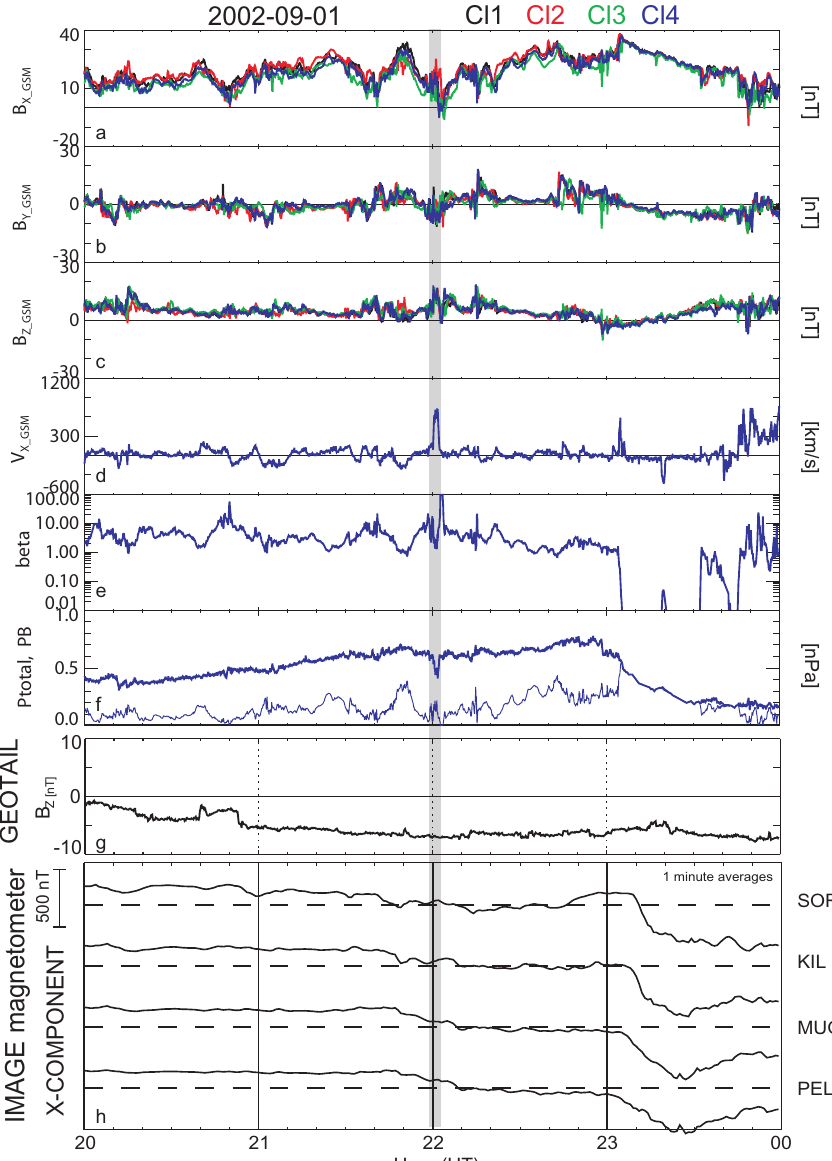
Fig. 2. Cluster, Geotail and ground magnetogram from selected MIRACLE stations between 20:00 and 24:00 UT, on 1 September 2002. Cluster observation of ( a ) X , ( b ) Y , and ( c ) Z component of the magnetic field from the four Cluster spacecraft, ( d ) X component of the ion flow, ( e ) proton beta, ( f ) total pressure (thick line) and magnetic pressure (thin line) for Cluster 4. Clusters 1, 2, 3 and 4 data are shown in black, red, green, and blue, respectively. ( g ) Geotail magnetic field data in the solar wind. ( h ) X component of the ground magnetic field data from selected MIRACLE stations. The grey vertical line indicates the bursty bulk flow event around 22:00